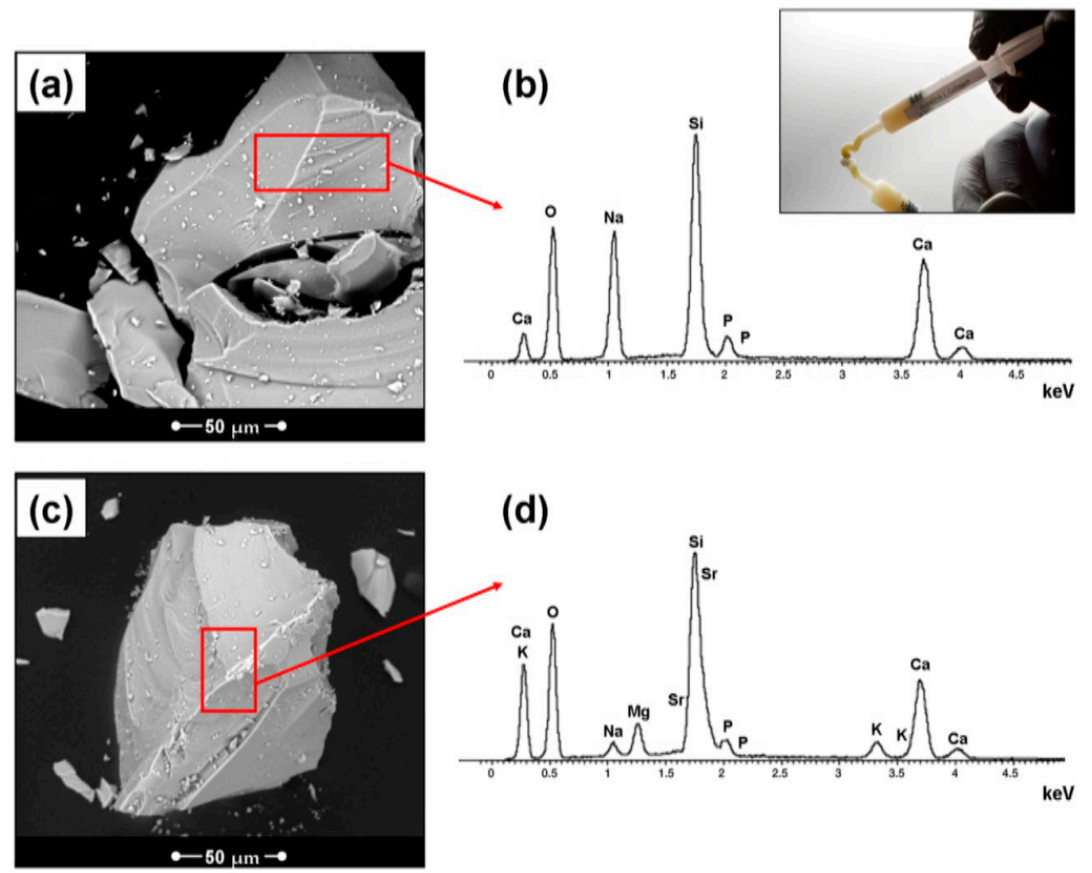
Figure 3. Morphological evaluation of the Bioglass ( a ) and BGMS10 ( c ) granules; ( b , d ) EDS results; inset: a BGMS/C putty syringe [57]. The red box, explain the selected area from the smaple for the EDX